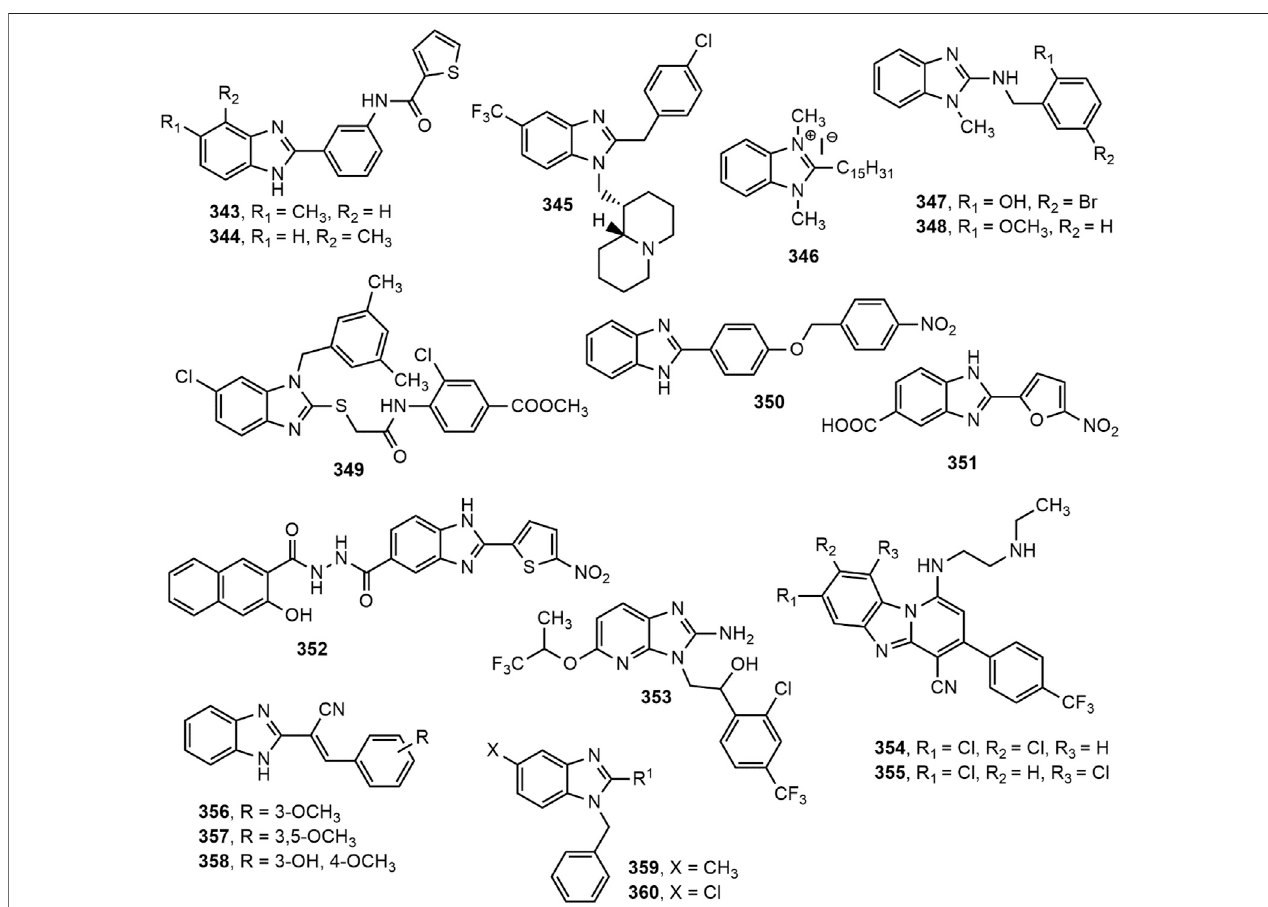
FIGURE 14 | Benzimidazole derivatives with antiprotozoal activity.